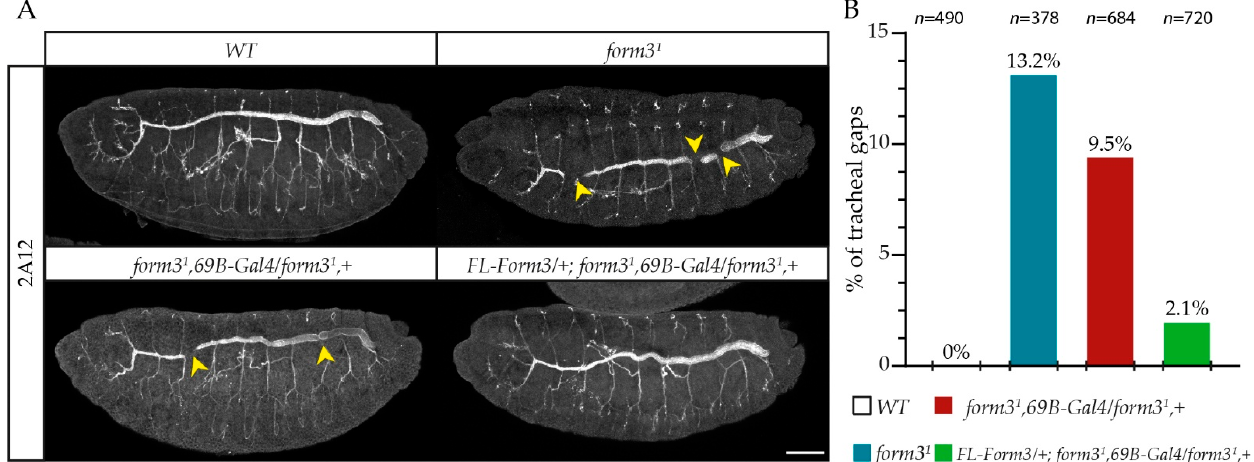
Figure 3. Form3 is required for tracheal development. ( A ) Stage 17 embryos of the genotypes indicated and stained for 2A12 to label the lumen of the tracheal system. Unlike the wild type, form3 1 mutant embryos display gaps in their main airways (arrowheads) that can be rescued with the expression of UAS-FL-Form3. Scale bar: 50 µm. ( B ) Quantification of the tracheal gap phenotype of the embryos indicated in panel A. w 1118 was used as the wild-type (WT) control.